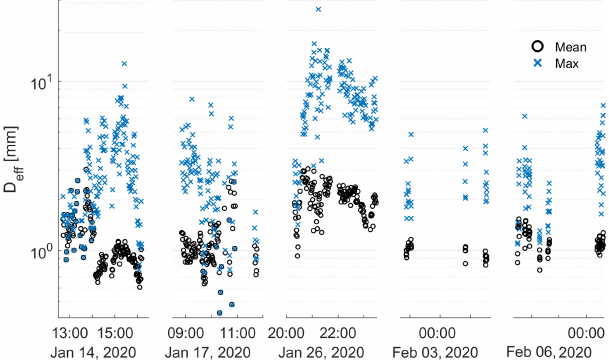
Figure 5. One-minute averaged maximum and mean effective di- ameters of measured